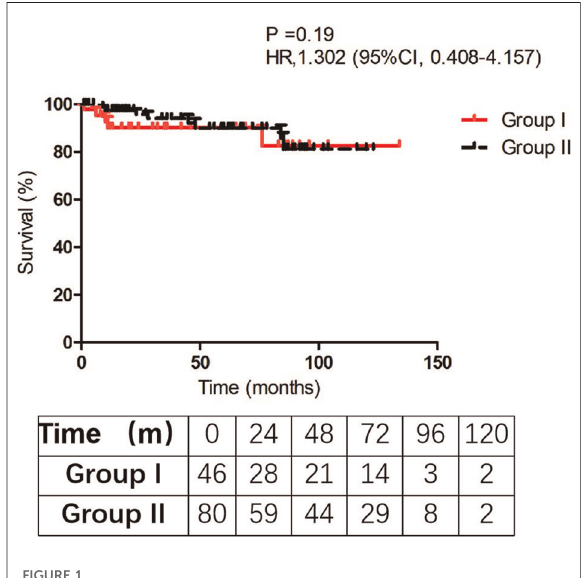
FIGURE 1 Survival rate of the two groups during the follow-up.